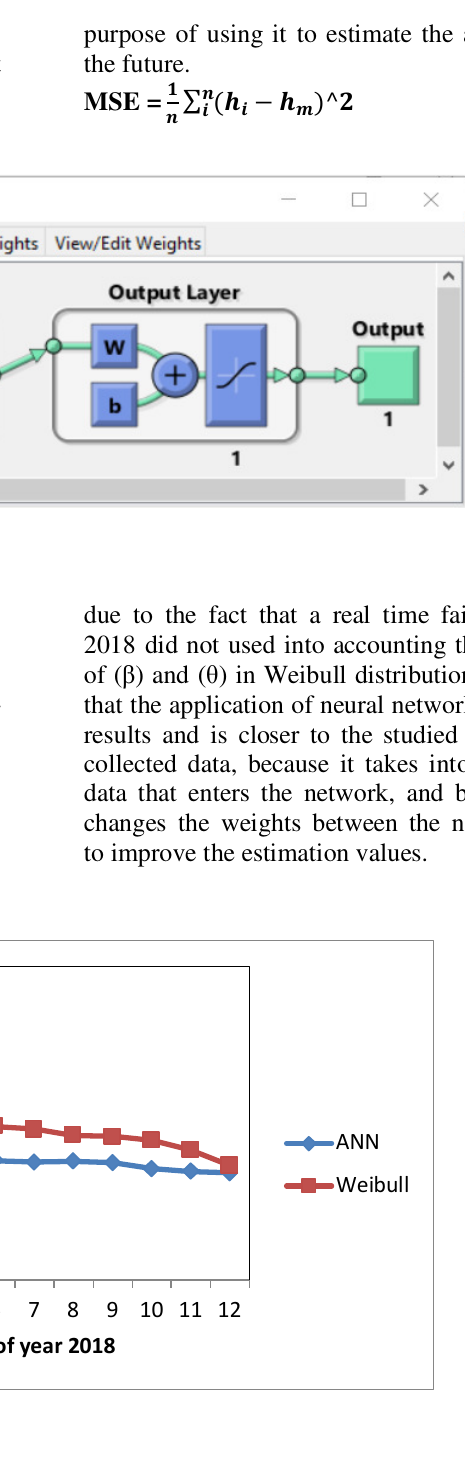
Fig. 7. A(t) of testing year 2018 by ANN & Weibull